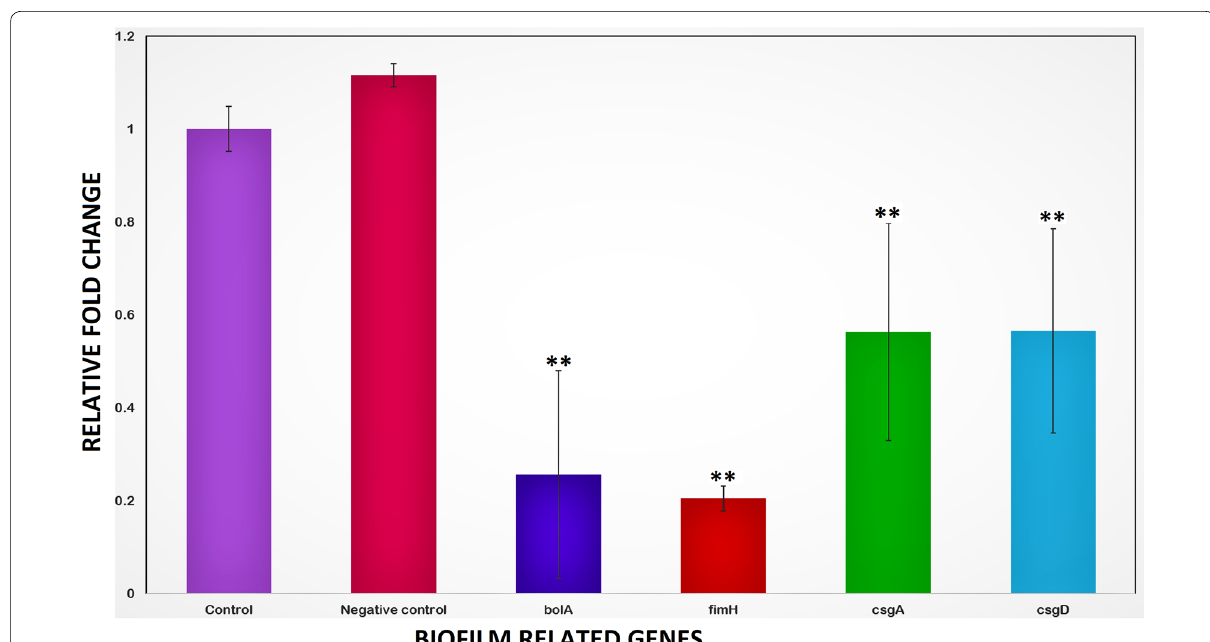
Fig. 2 Relative qRT-PCR data of different genes ( fimH , csgA , and csgD ) in CRISPRi mediated bolA knocked down E. coli cells ( bol -KD). The control cells consist of pdCas9 and empty pgRNA plasmids while negative control are cells without plasmid. The data represent an average of triplicate